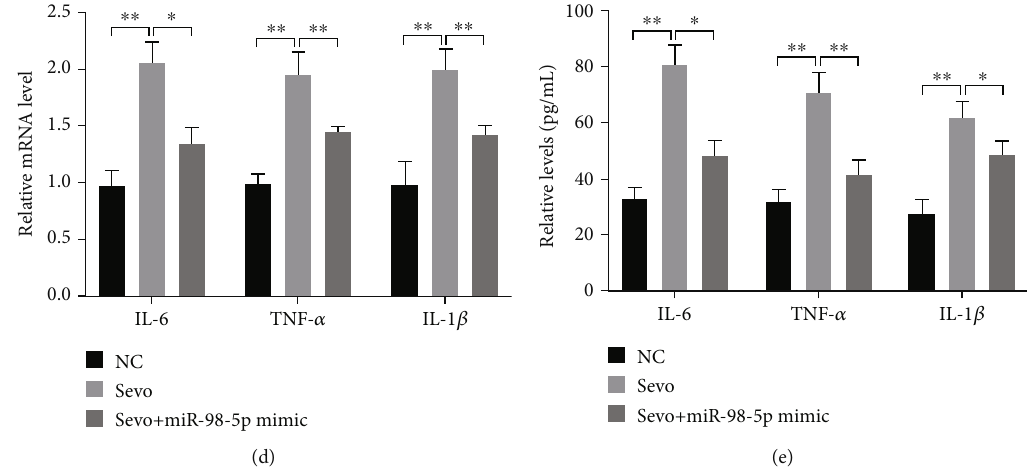
Figure 4: E ff ects of miR-98-5p on sevo fl urane-induced neuronal apoptosis and in fl ammation in vitro. (a, d) RT-qPCR for detection of HOXA11-AS and mRNA expression of in fl ammatory factors. (b) TUNEL staining to detect neuronal apoptosis. (c) Western blot detection of apoptosis-related protein expression. (e) ELISA detects the in fl ammatory factors levels. ∗∗ P < 0 : 01